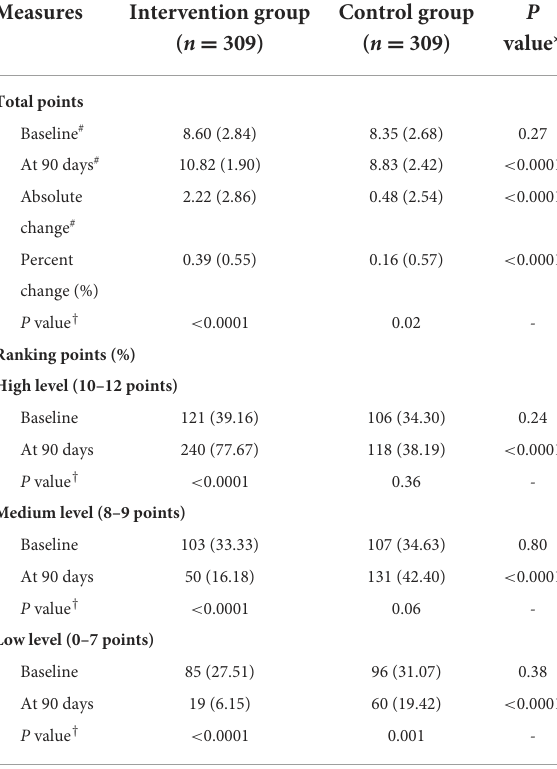
TABLE 8 The medication behavior security evaluation of elderly patients with multimorbidity. Measures